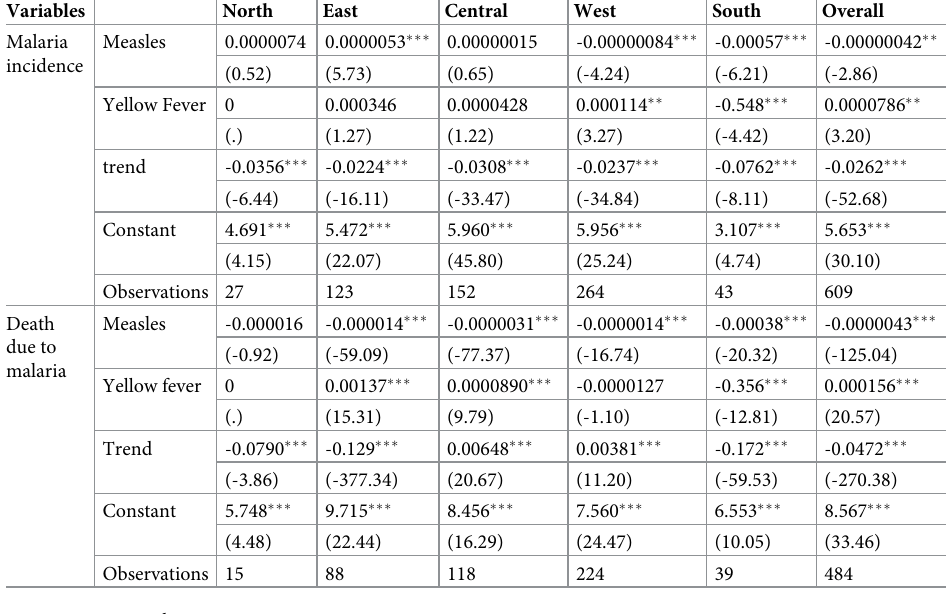
Fig 2. Spatial Distribution of Measles (A) and Yellow Fever Cases (B) in Africa. https://doi.org/10.1371/journal.pone.0268080.g002 Table 2. Malaria incidence and death due to random effect panel